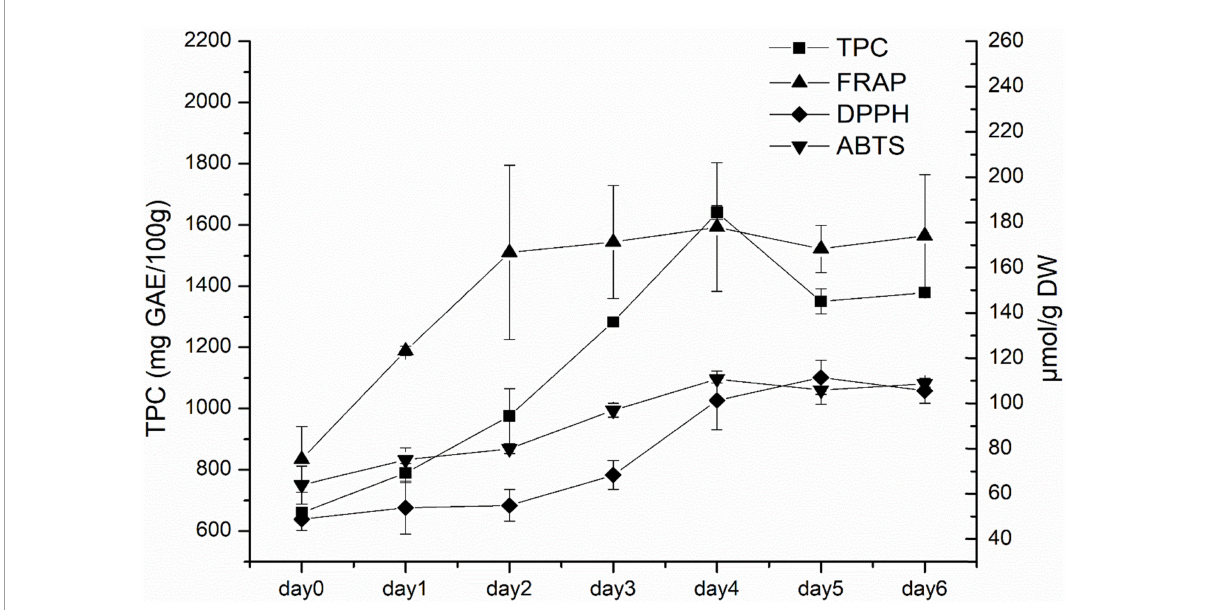
FIGURE2 The TPC and antioxidant capacities (ABTS, DPPH, and FRAP) of white radish during germination.